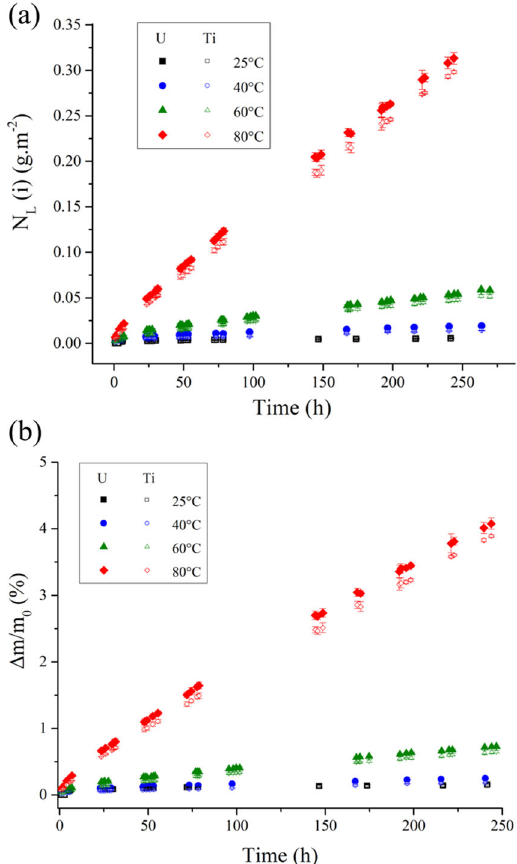
Fig. 3 Dissolution of brannerite in 2 mol/L H 2 SO 4 . Evolution of the normalized weight losses N L (i) (g/m 2 ) ( a ) and of the relative mass losses Δ m i / m 0 (%) ( b ) obtained during the dissolution of synthetic brannerite sample in 2 mol/L H 2 SO 4 solution for various Fig. 6. The impact of the sulfuric acid concentration was stronger when introducing Fe(III) in the solution. For instance, at 25 °C, the normalized dissolution rate R L (U) increased by a factor of 9.4, from (3.3 ± 0.1) × 10 − 5 g/(m 2 h) to (3.09 ± 0.06) × 10 − 4 g/(m 2 h), when the acid concentration raised from 0.1 to 2 mol/L (Table 1). Once again, the impact of the acid concentration was even more pronounced at high temperature since an increase of R L (U) by a factor of 41 was observed at 80 °C when the acid concentration increased from 0.1 to 2 mol/L (i.e., from (2.9 ± 0.1) × 10 − 3 to (1.20 ± 0.03) × 10 − 1 g/(m 2 h)).